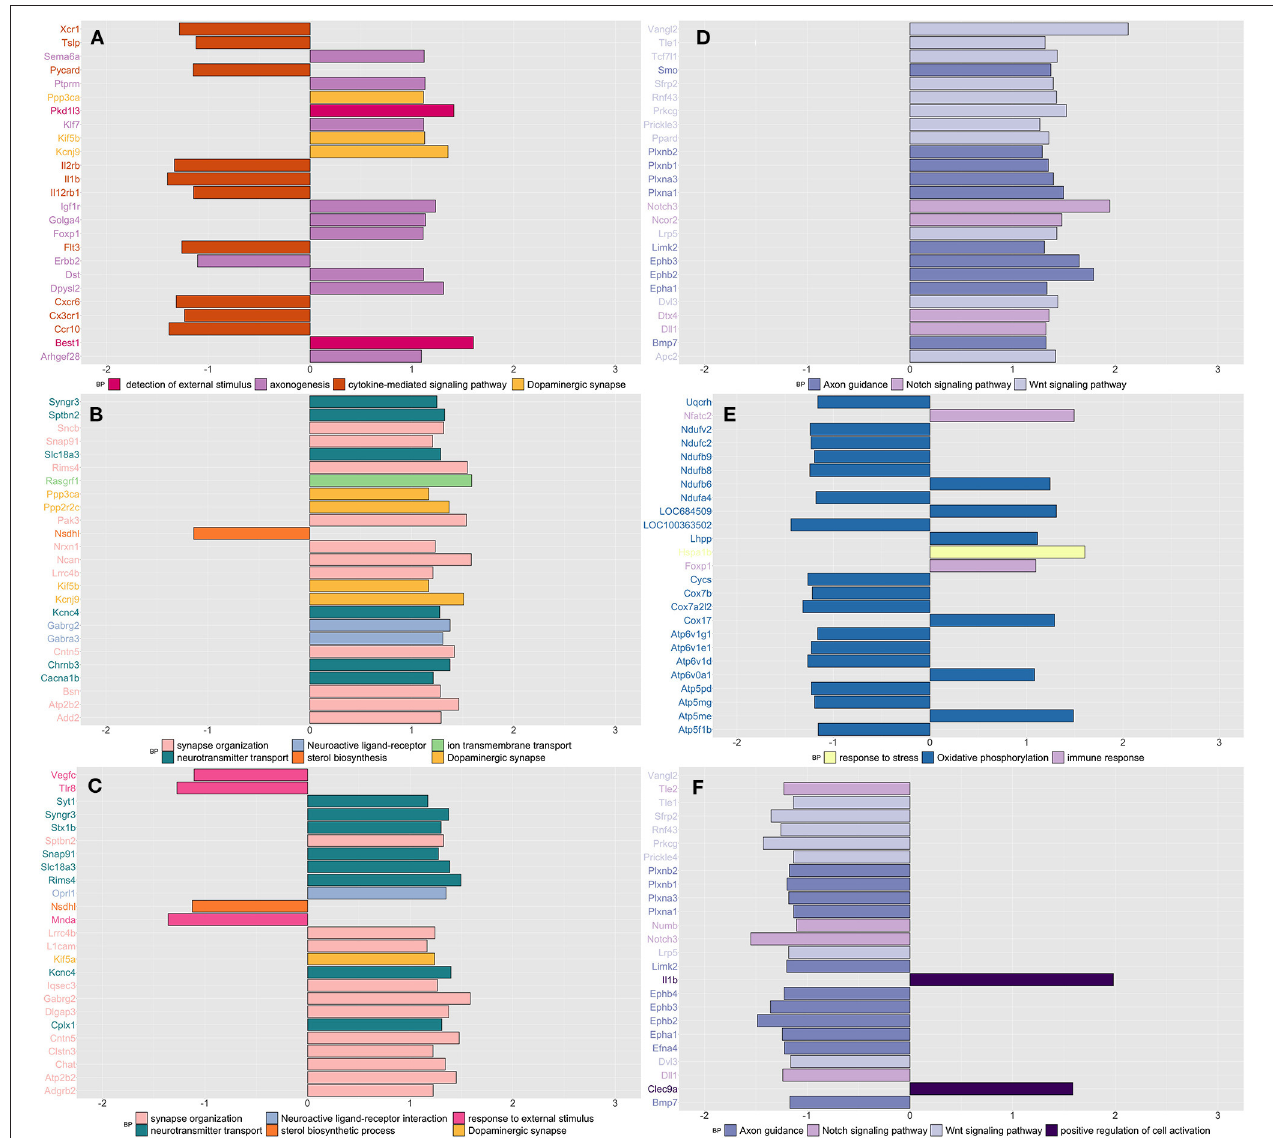
FIGURE 2 | Summarizes the results of both gene-set and gene differentially expressed (DE) in colon tissue across conditions and time. We focused on the top DE gene-sets and top 25 most significant DEGs that were enriched mostly in inflammatory and neurological pathways. (A) SIH vs. Naïve at week 1, (B) CPH vs. Naïve